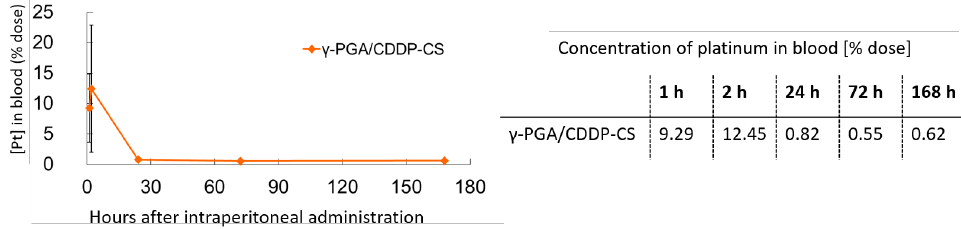
Figure 4. Blood concentration of γ -PGA/CDDP-CS in mice. γ -PGA/CDDP-CS was measured until 168 h after administration. The maximum concentration of platinum in the blood (% dose) was 12.5% ± 10.4%. Data are represented as mean values ± standard error of the mean (SEM).